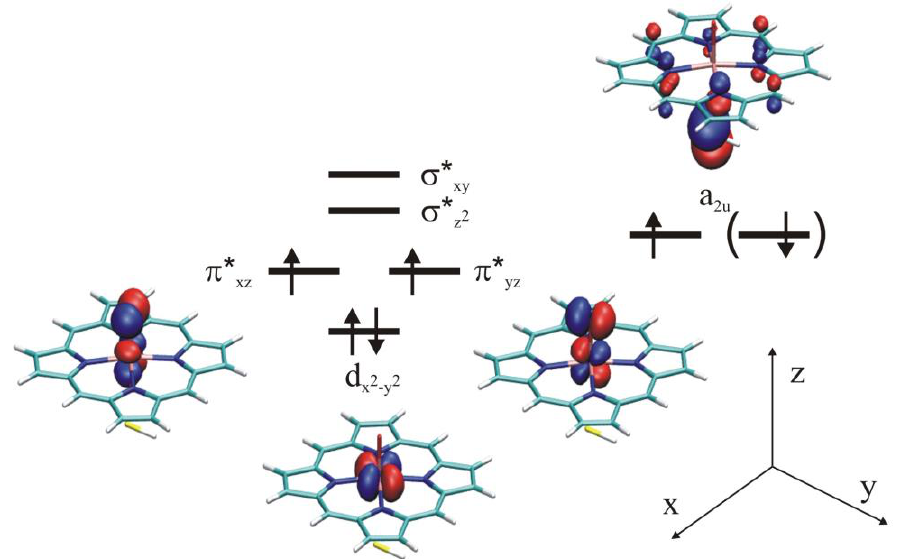
Figure 11. Singly occupied molecular orbitals of Compound I.